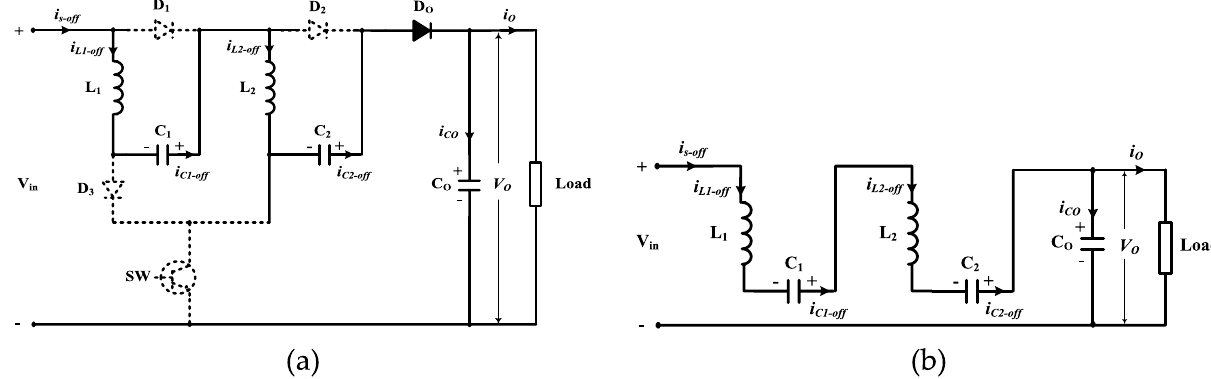
Figure 5. Equivalent circuit of Mode 2: ( a ) active and inactive elements, and ( b ) equivalent electrical